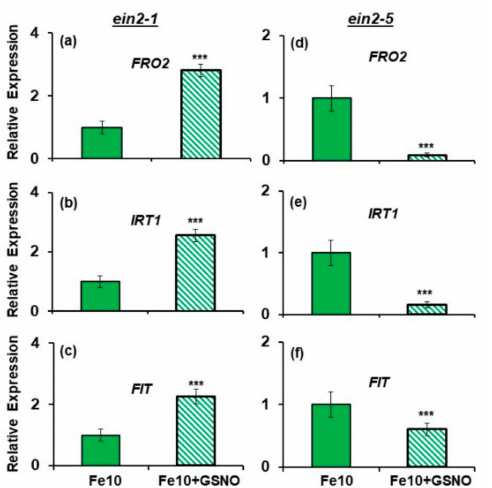
Figure 7. Effect of GSNO (NO donor) on FRO2 , IRT1 and FIT expression in roots of the Fe-sufficient Arabidopsis ET insensitive mutants ein2-1 ( a – c ) and ein2-5 ( d – f ). Plants were grown in complete nutrient solution with 10 µ M Fe-EDDHA (Fe10). GSNO, at 100 µ M final concentration, was added to the nutrient solution of half of the plants during the last 24 h. After treatments, roots were collected and kept at − 80 ◦ C for subsequent analysis of mRNA levels. FRO2 , IRT1 and FIT expression were determined. Relative expression was calculated in relation to the Fe10 treatment. Data represent the mean of 3 independent biological replicates ± S.E. Bars with *** indicate significant differences ( p < 0.001) in relation to the Fe10 treatment according to the Student’s test t .